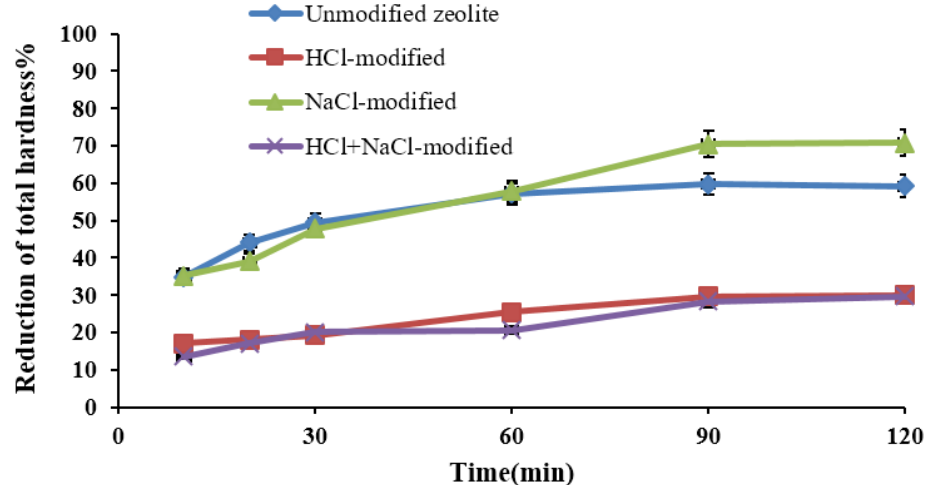
Figure 5. The effect of contact time on the decrease in total hardness (%) for groundwater by modi- fied zeolite at 60